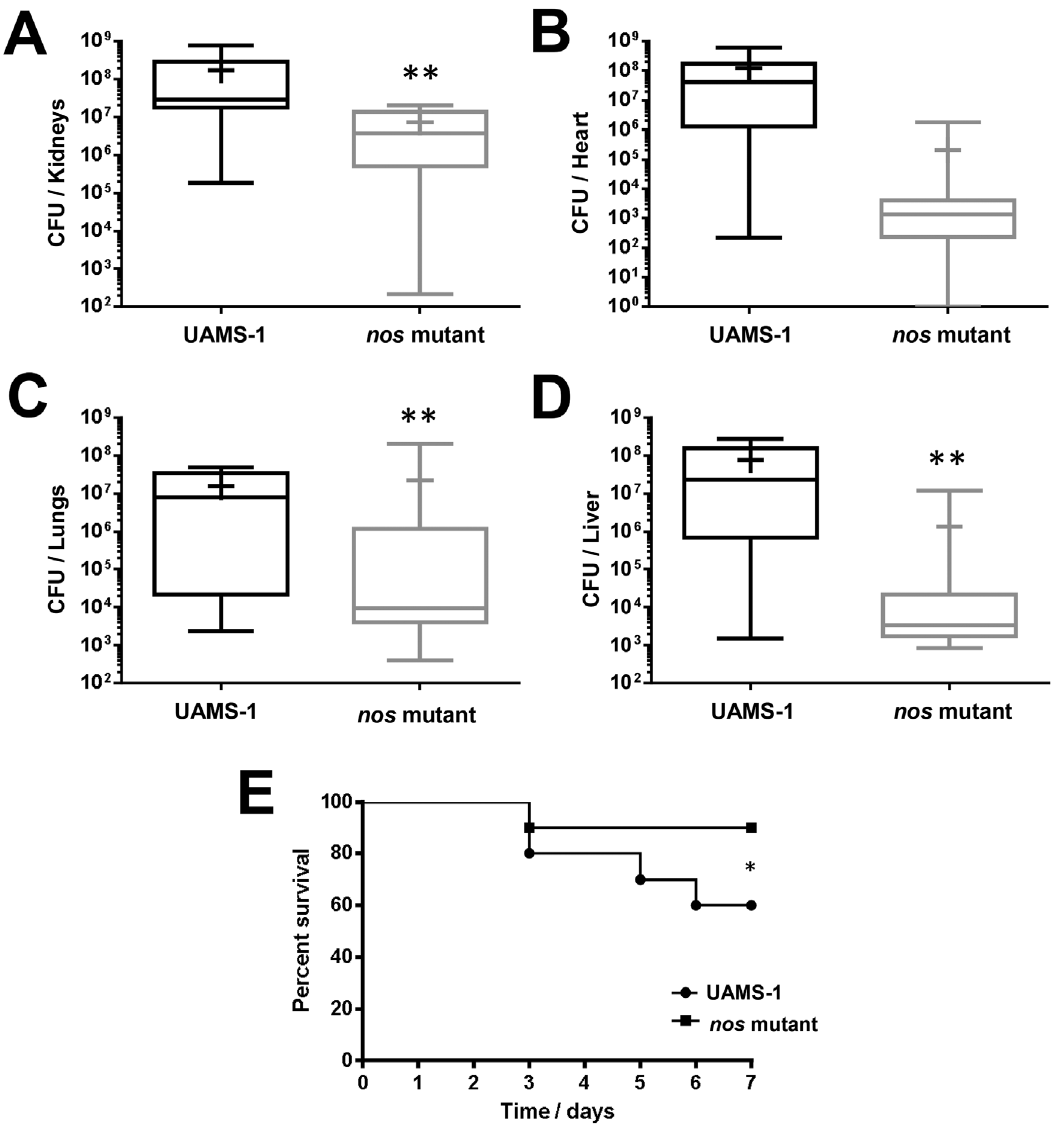
Figure 8. Effect of nos on S.aureus virulence. 1 6 10 8 CFU/ml of UAMS-1 (wild-type) and KR1010 ( nos mutant) cultures were each injected into the tail veins of female CD-1 Swiss mice (n=9 mice per group). The infection proceeded for 7 days, or until mice reached a pre-moribund state (used as a measure of mortality). Mice were then euthanized and organs were collected and stored at 2 80 u C prior to homogenization and determination of recovered CFU/organ. Graphs represent the calculated bacterial burdens for the kidneys (A), heart (B), lungs (C) and liver (D), and the percent survival (E). For A–D, data are graphed as box-whisker plots, indicating the 25 th , median, and 75 th percentiles (box lines), the 90 th and 10 th percentiles (error bars), and mean ( + ) of each data-set. *denotes statistically significant difference of mortality (p , 0.05, Log Rank and Chi Squared Test with 1-degree of freedom), **denotes statistical significance of bacterial recovery (p , 0.05, Mann-Whitney Test). doi:10.1371/journal.pone.0108868.g008 mutants. Staphyloxanthin, the major carotenoid pigment synthe- observed, since maximal expression of crtM has been shown to sized by a series of enzymes encoded by the crt operon [43], has occur in stationary phase in planktonic culture [46]. Although loss been shown to be a potent antioxidant defense against hydrogen of saNOS does not appear to alter expression of the crt operon and peroxide and the immune cell respiratory burst [48,49], as well as regulators of crt expression when grown on TSA plates (Fig. 6B), it conferring tolerance to host antimicrobial peptides [50] and fatty is possible that NO derived from saNOS may regulate the activity acids [51] by altering membrane fluidity. Therefore, at first glance, of one or more of the enzymes involved in the synthesis of it appears paradoxical that a S. aureus nos mutant would be more staphyloxanthin or one of its precursors. Another possibility stems sensitive to oxidative stress while displaying increased carotenoid from the fact that the degree of conjugation (increased number of pigmentation. However, the hydrogen peroxide challenge assay double bonds) in carotenoids tends to correlate to the observed utilized in this study was performed during mid-exponential intensity of orange-yellow pigmentation [52]. Since NO is known growth phase in planktonic cultures, a growth condition under to have an affinity for biological membranes [53] and can attack which differences in staphyloxanthin production is unlikely to be the double bonds of b -carotene [54], it is possible that increased